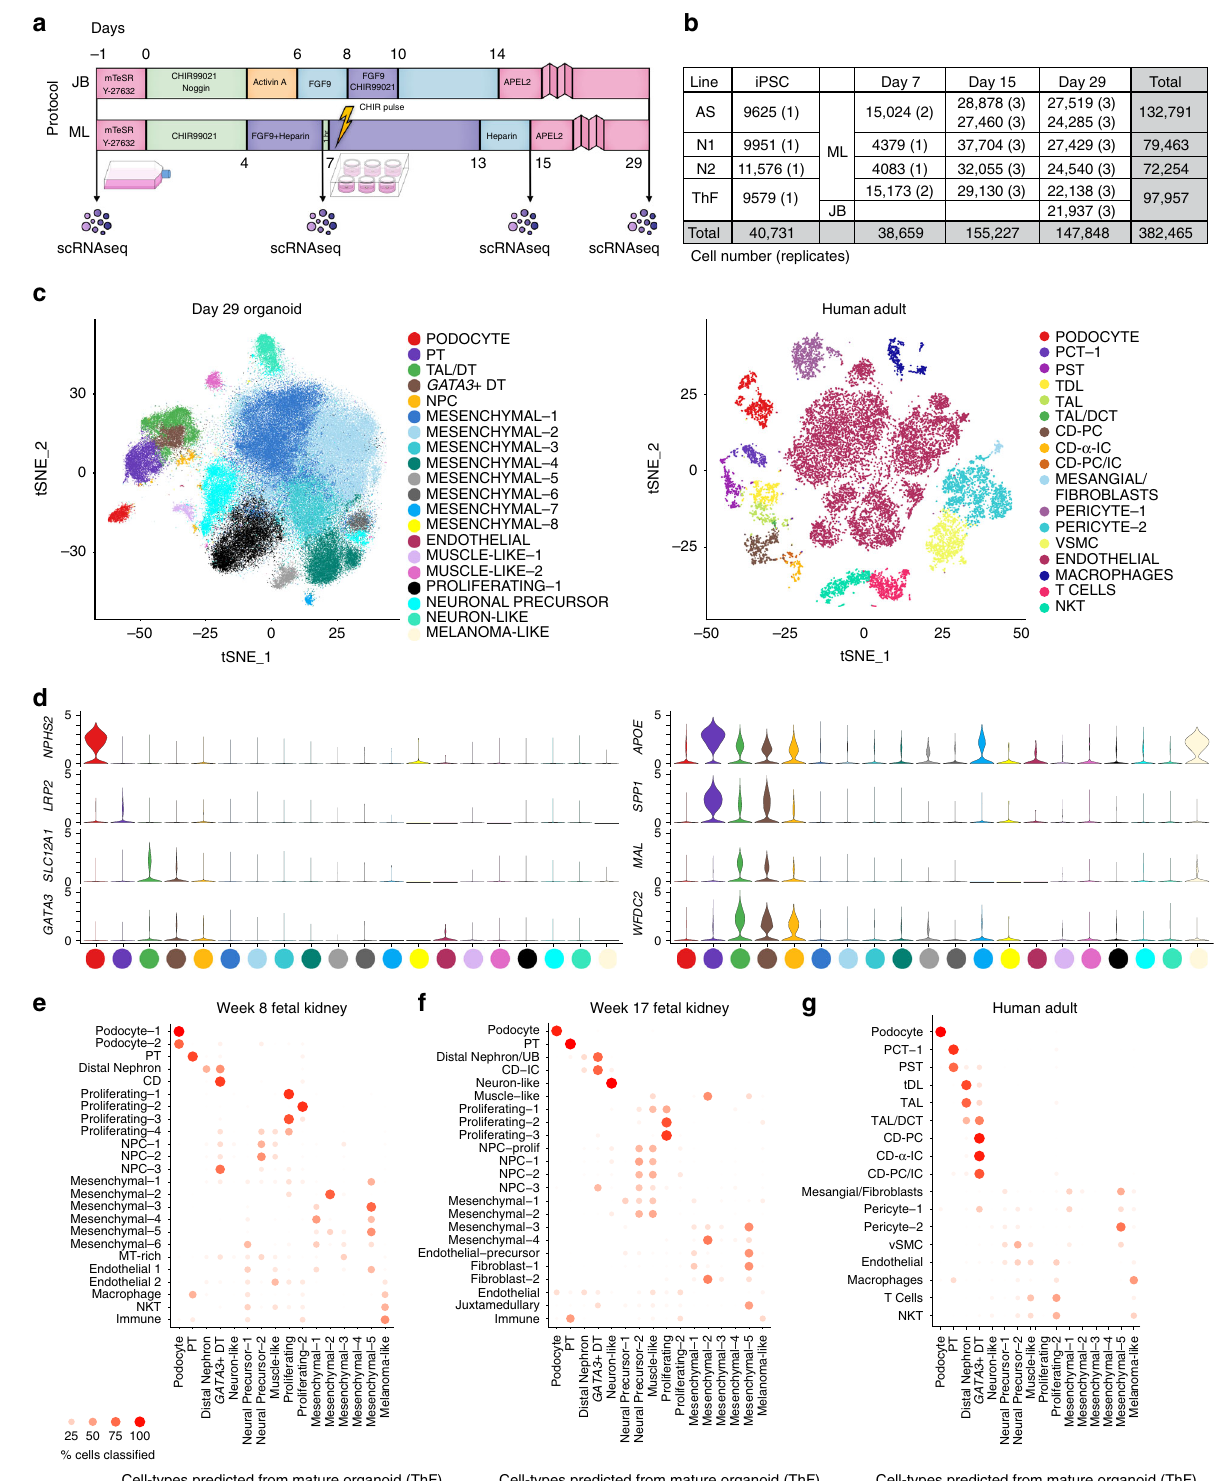
Fig. 5C). In all cases, we identi fi ed the same nephron cell types as predicted by the random forest (RF) classi fi er: podocytes, PT, TAL and distal nephron cells. Joint clustering of fetal